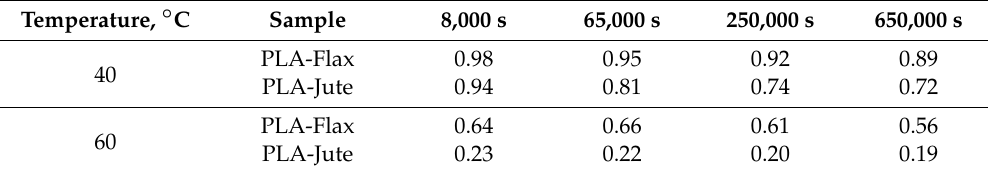
Table 3. Ratios between normalized deformation of the composite and normalized deformation of neat PLA at specific